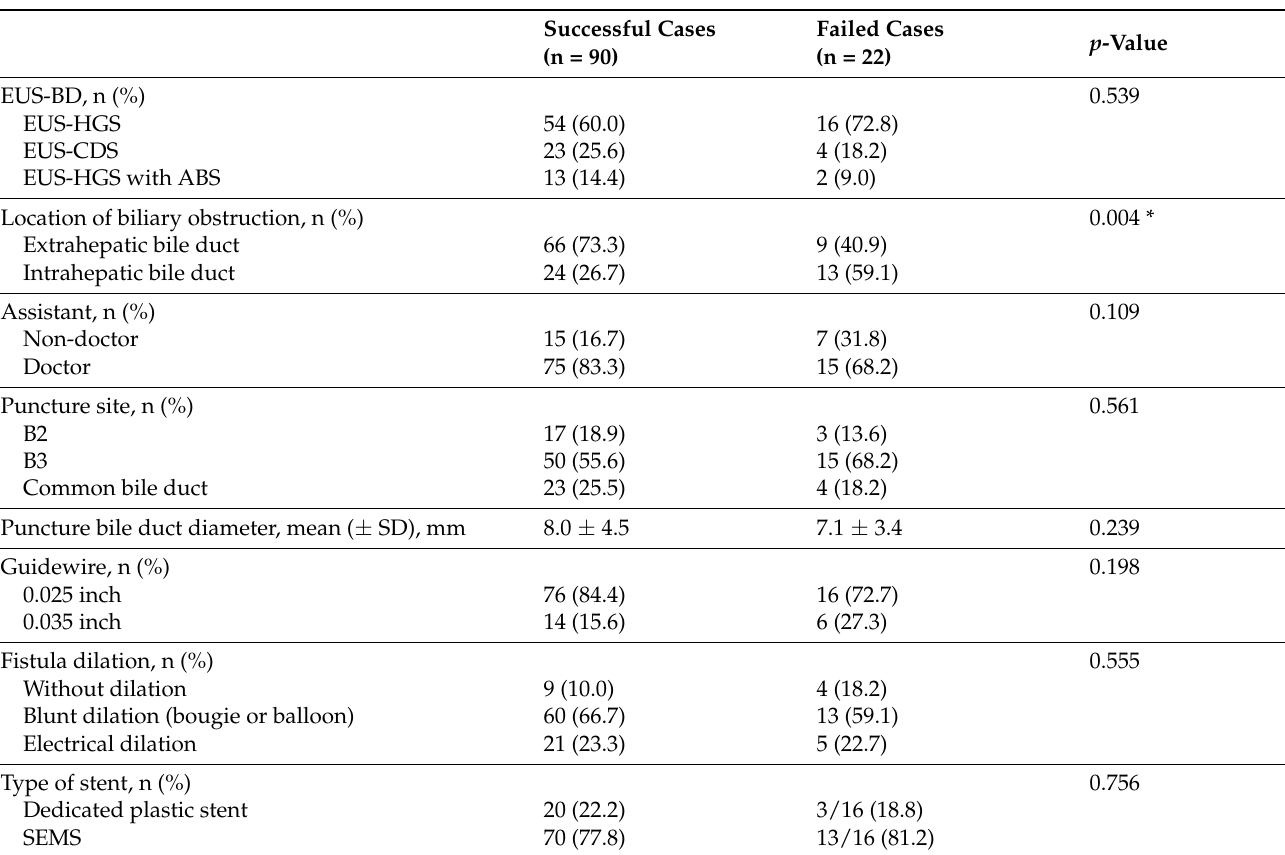
Table 3. Procedure-related